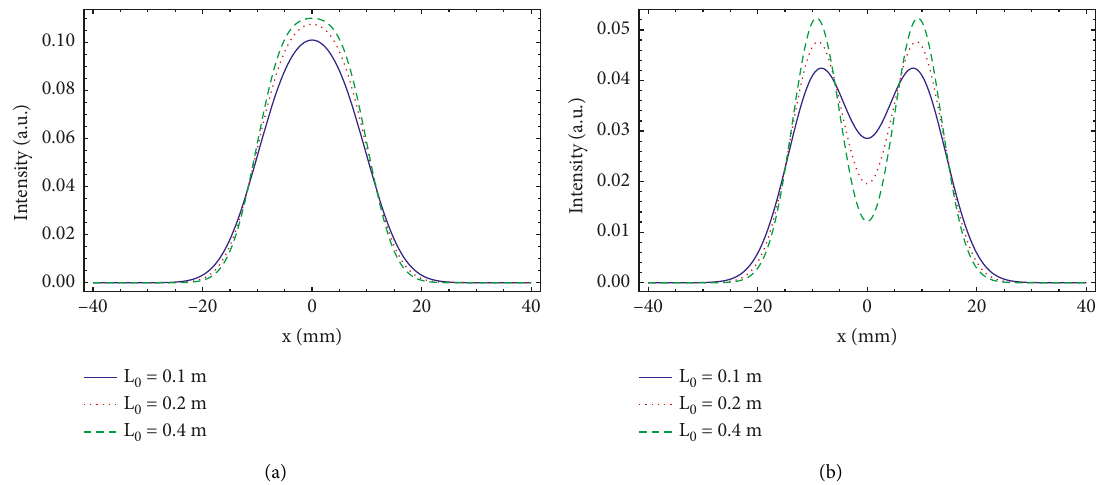
Figure 4: Cross-sections of the intensity distribution of the partially coherent circular: (a) flat-topped nonvortex beam and (b) flat-topped vortex hollow beam in anisotropic turbulent plasma for different values of the outer scale L 0 ( z